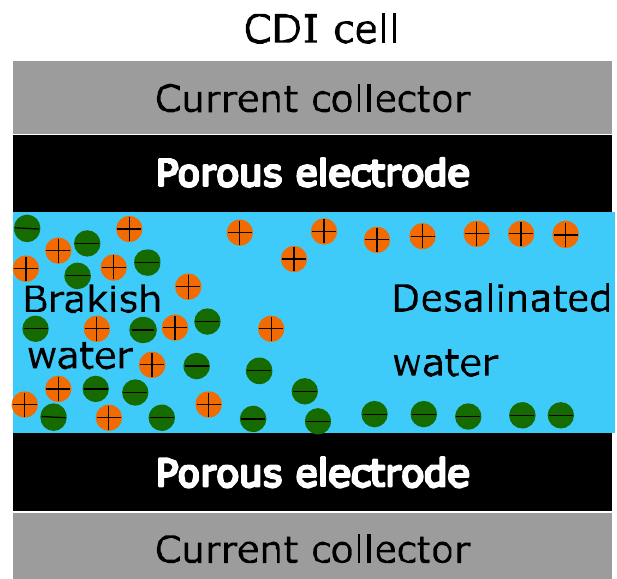
Figure 1. Capacitive deionization cell (CDI).